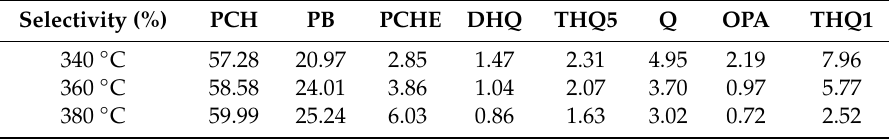
Table 6. Product distribution of the NiW/Al-KT-80 catalyst in quinoline HDN. Selectivity (%) PCH PB PCHE DHQ THQ5 Q